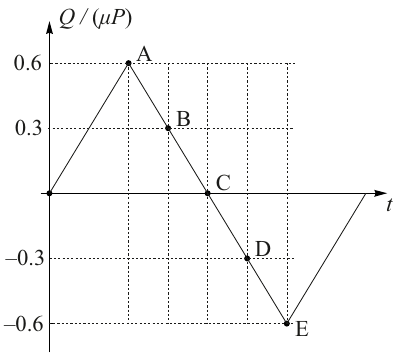
Figure 4. Scheme of the tangential loading history for the exemplary calculation; A, B, C, D and E denote instants of the loading protocol, for which the stress state will be